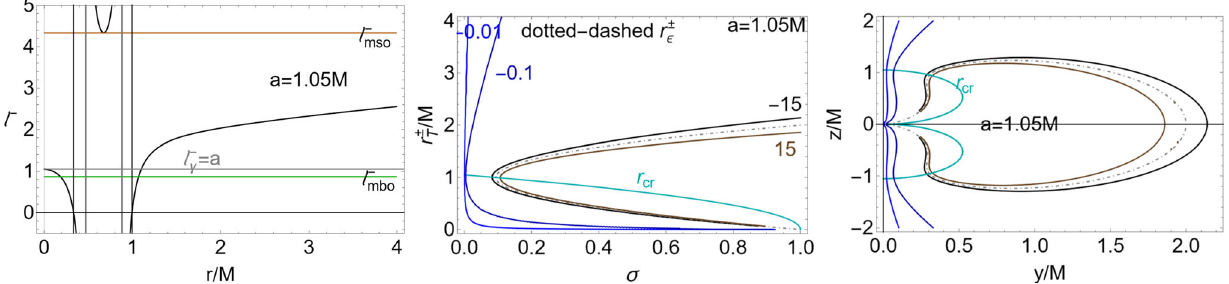
Fig. 7 Double co-rotating tori system with fluid specific angular momentum (cid:6) = (cid:6) − . Gray vertical lines are r ± δ , black vertical lines r ± The specific angular momentum (cid:6) = (cid:6) − ( r ) , the associated effective potentials V ef f for NS spin-mass ratio a = 1 . 01 M and (cid:6) − according to the colour notations of the (cid:6) − − r / M panels. The inversion points r ± (cid:2) are also plotted as functions of the plane σ = sin 2 θ ∈ [ 0 , 1 ] (where σ = 1 is the equatorial plane) for different (cid:6) signed on the curves. Here the most general solutions r ± (cid:2) are shown not considering constraints of Sect. 3.2. For (cid:6) − > 0 inversion points are only for space-like parti-